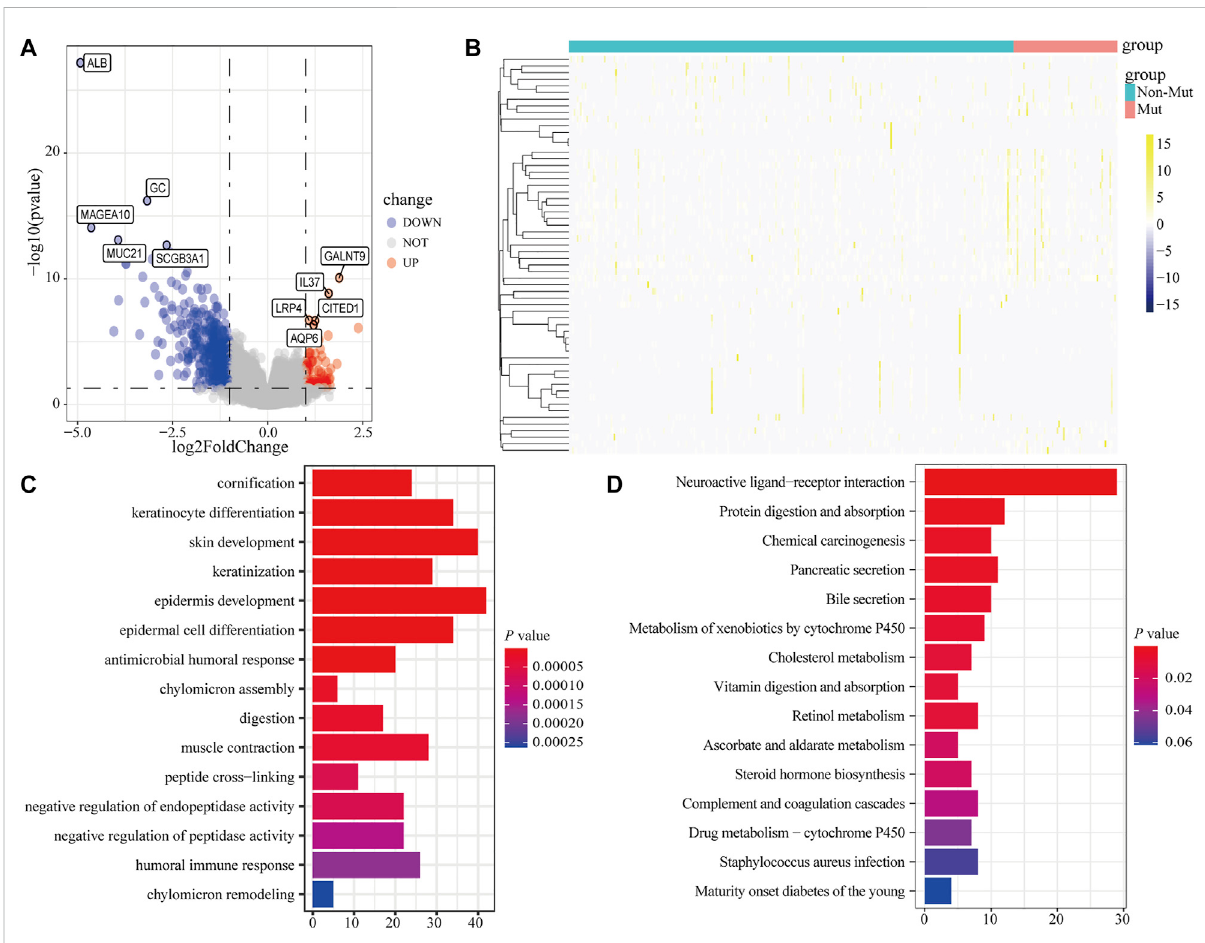
FIGURE 6 Functional enrichment analysis of the differentially expressed genes based on FLG gene mutation. (A,B) Volcano plot and heatmap show the expression of DEGs between FLG -mutant and non-mutant groups. (C) Based on CC, BP, and MF levels, GO analysis suggests that differentially expressed genes are closely related to corni fi cation, keratinocyte differentiation, skin development, endoplasmic reticulum lumen, and corni fi ed envelope biological processes. (D) KEGG analysis showed that these differentially expressed genes were participated in the neuroactive ligand – receptor interaction, protein digestion and absorption, chemical carcinogenesis, and pancreatic secretion and other biological related signaling